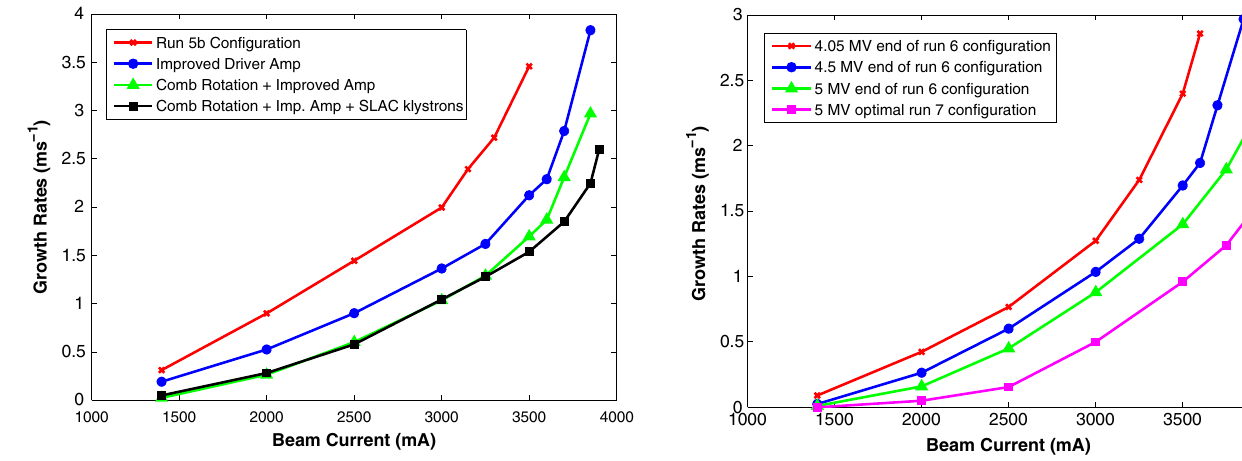
FIG. 12. (Color) Estimated growth rates at 4.5 MV. FIG. 14. (Color) Comparison of simulation growth rates for different gap voltage settings.